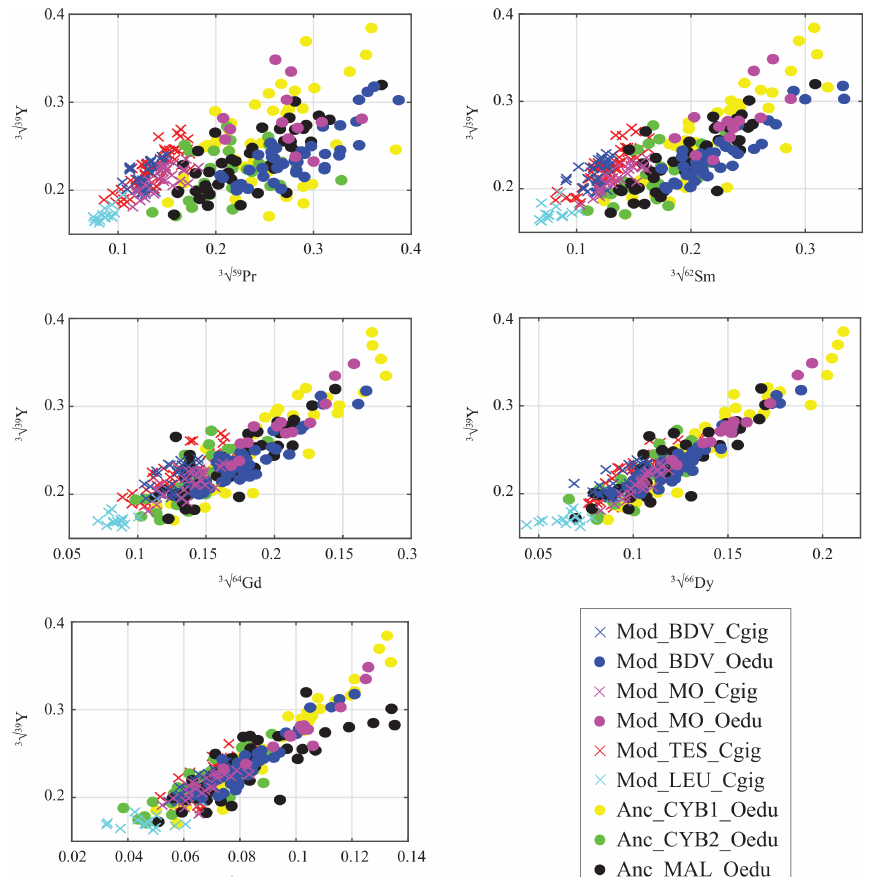
Figure 4. Gradual decrease in REE abundances in oyster shells according to the REE atomic number, presented against Y. Values are expressed in the cubic root of abundances (µgg − 1 ) to approach normality. Measurements from C. gigas and O. edulis are indicated by crosses and filled circles,